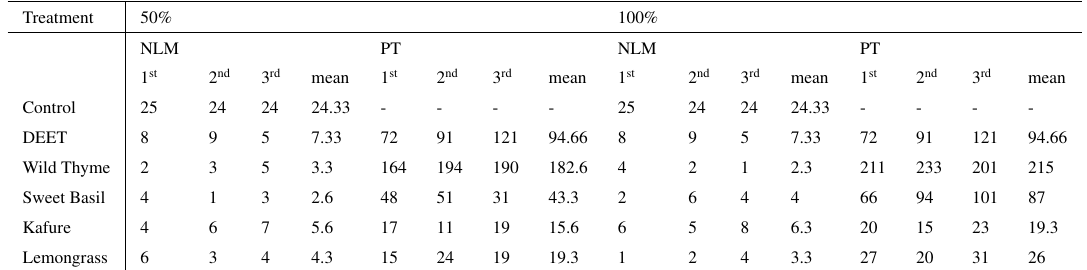
Table 6. Spatial repellent activity and protection time per minute (PT)of 50 and 100% of evaluated plants leaves hexane and ethanol extract mixture against Anopheles mosquito. Treatment